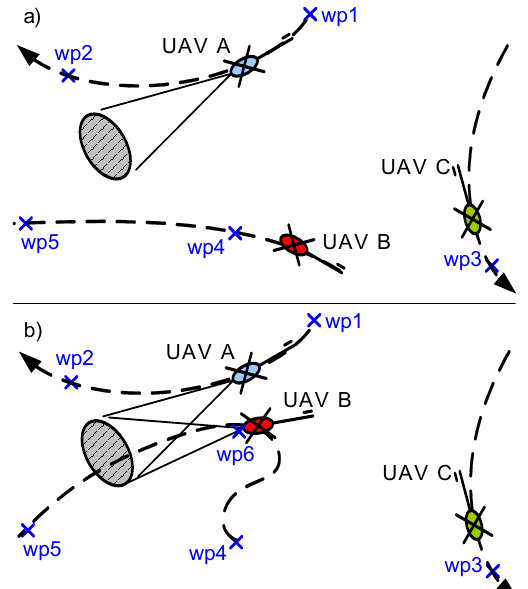
Figure 6. An example illustrating the re-planning process: (a) UAVs following the initial plan. (b) Dynamic replanning: UAV B plan changes to include